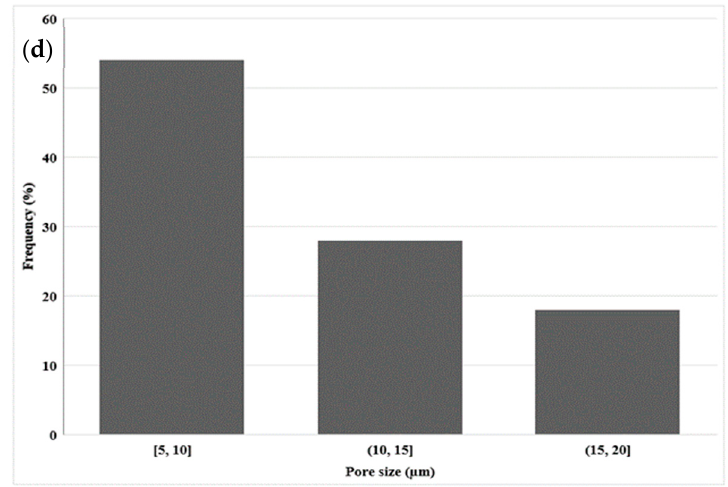
Figure 4. SEM images of: ( a , b ) the cross-section of the LDPE membrane (extrusion) at different mag- nification, ( c ) longitudinal section of the LDPE membrane (extrusion), and ( d ) pore size distribution inside the LDPE membrane.